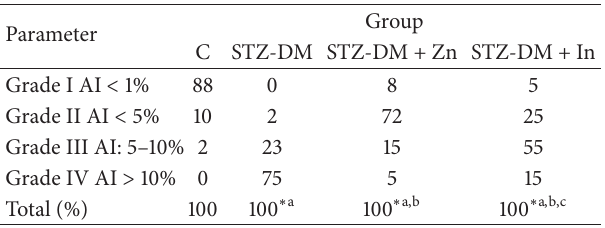
Table 5: Percentage frequency distribution of apoptotic index (AI) in caspase-3 immunohistochemical stained myocardial sections in the different groups.